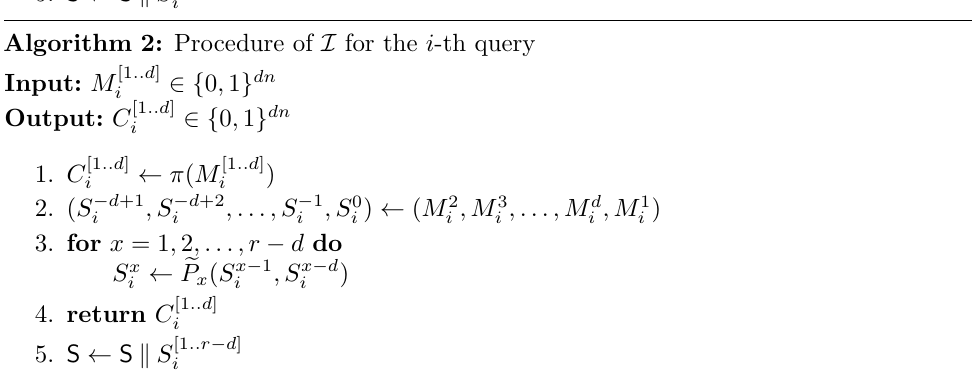
Figure 6: Definition of R and I for the PRP proof of E 1 ,d,r . Initially, S is empty, and S is given to A after it makes all the q